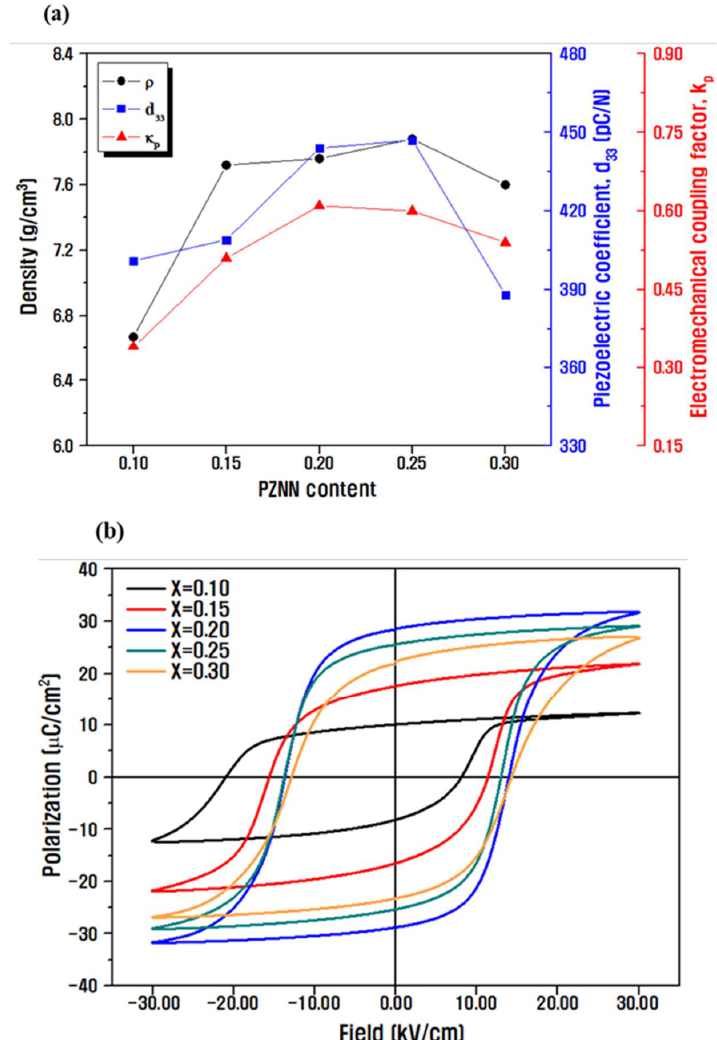
Figure 3. Measurements of the ( a ) densities and electrical properties ( d 33 , k p ) of the ceramics sintered at 900 ◦ C with different contents of PZNN, and ( b ) the corresponding polarization–electric-field (P–E) hysteresis loops.